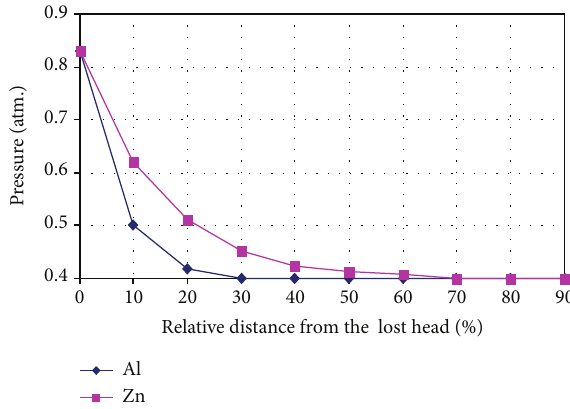
Figure 6: Gas pressure on the line of melt